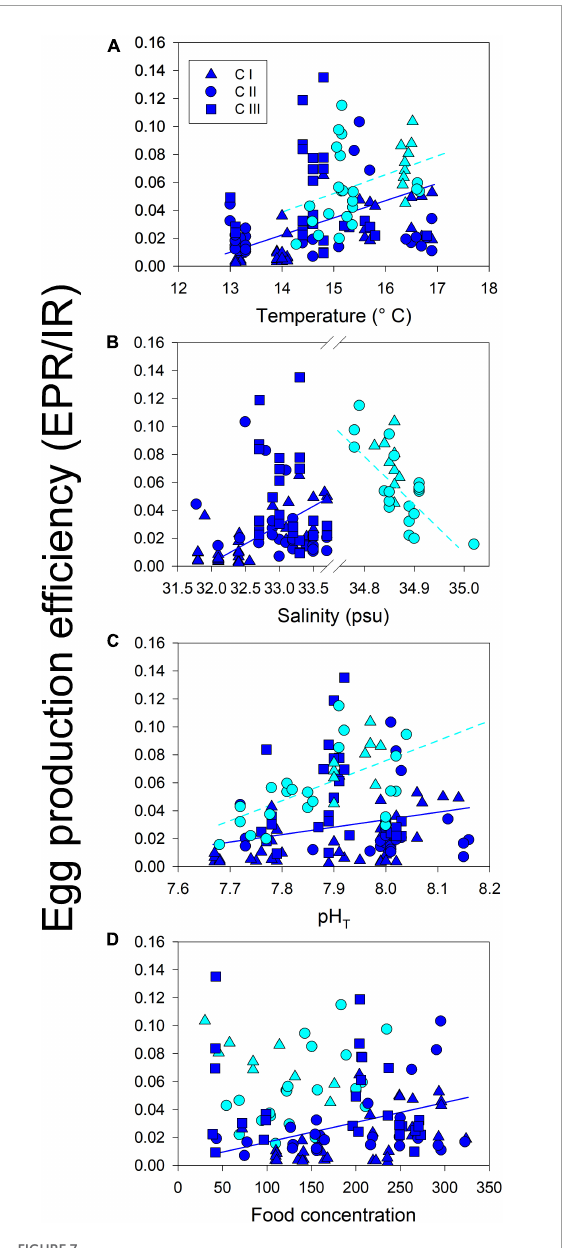
FIGURE7 Phenotypic plasticity of EPE (EPR/IR quotient) to sampling temperature (A) , salinity (B) , pH T (C) and food (D) in each habitat. Plastic responses were expressed as a mean reaction norm that had a significantly non-zero slope. The slope denotes the EPE tolerance to the respective